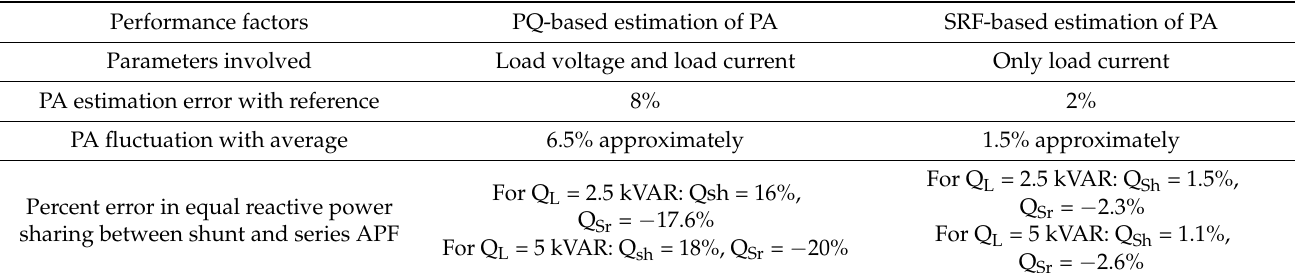
Table 3. Comparative analysis between PQ and SRF methods for PA estimation. Figure 12. Comparative performance analysis between PQ and SRF methods: ( a ) PA estimation by PQ method; ( b ) PA estimation by SRF method; ( c ) reactive power share by PQ method; ( d ) reactive power share by SRF method.